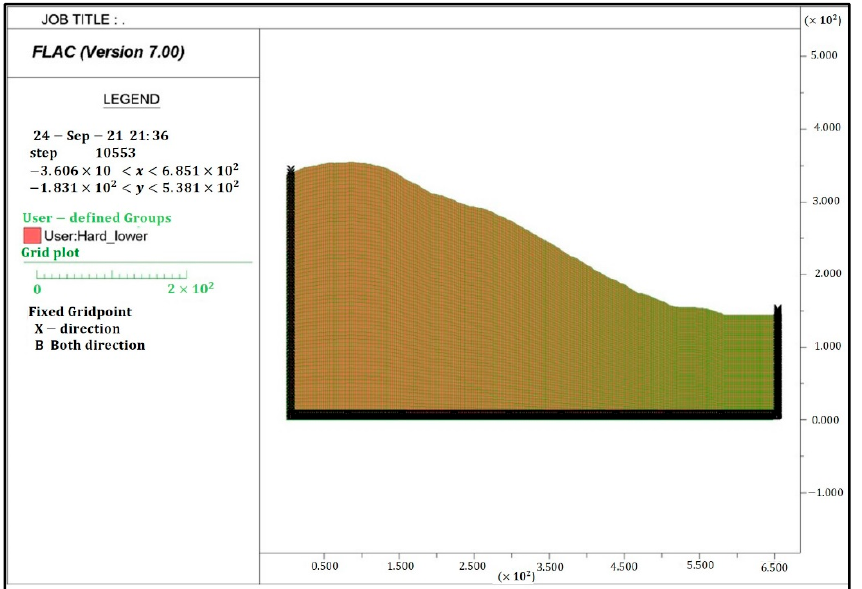
Figure 5. Illustration of the model slope constructed using DTM5 before the 2005 event, and no lateral displacement for the lateral boundaries and fixed boundary at base were assigned.